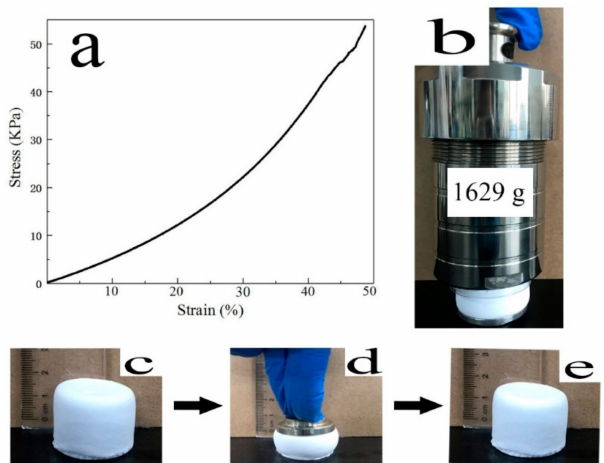
Figure 3. ( a ) Stress–strain curve, ( b ) aerogel-like monolith supports a weight of 1629 g, and ( c – e ) compression test.